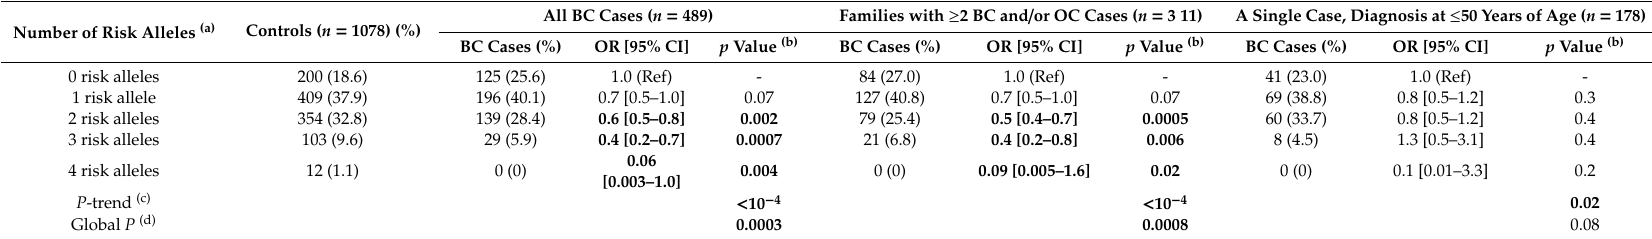
Table 3. Combined e ff ects of rs2242442 ( TBX3 ) and rs10497520 ( TTN ) on the risk of breast cancer.